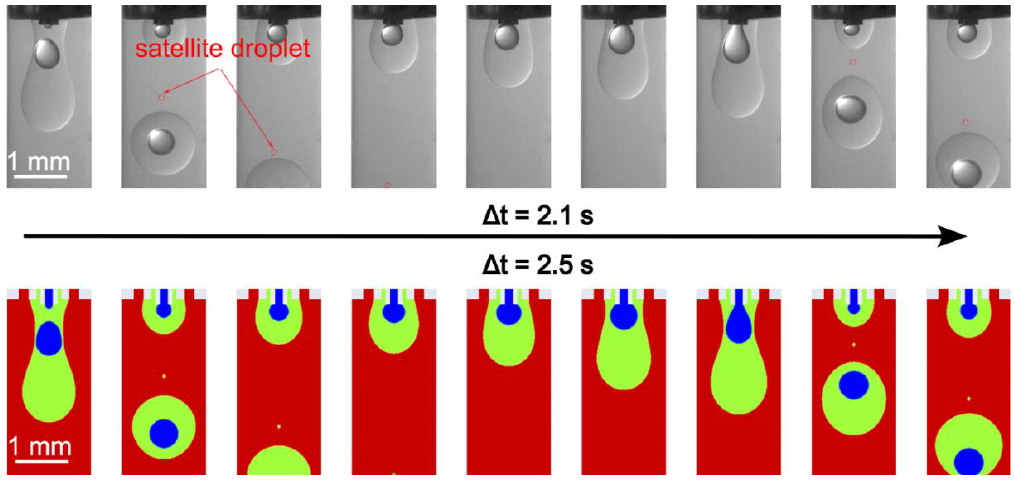
Figure 4. Droplet formation with regular double emulsions at Q 1 = 3 µL/min, Q 2 = 30 µL/min, Q 3 = 250 µL/min.